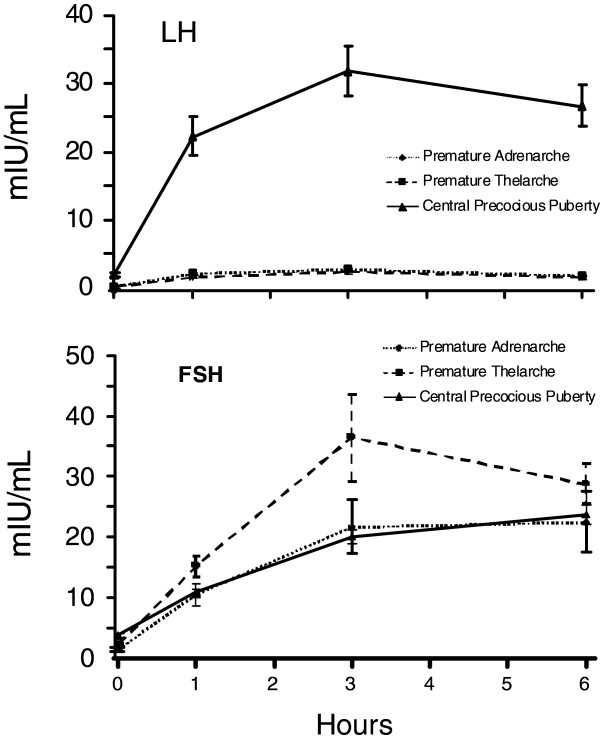
Baseline and peak stimulated serum LH (upper panel) and FSH (lower panel) concentrations (mean ± SEM) at 1, 3, and 6 hours after leuprolide injection. LH concentrations in central precocious puberty were significantly higher than in either the children with premature thelarche or premature adrenarche (P< 0.005).